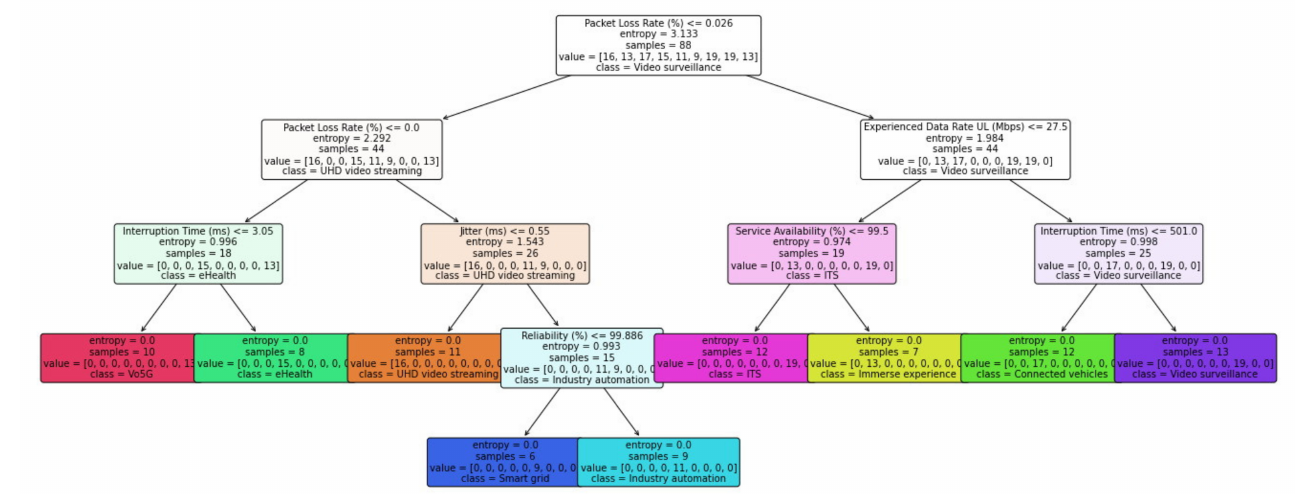
Figure 5. Scheme of one Decision Tree of the Random Forest for the second simulation (KPIs + KQIs).